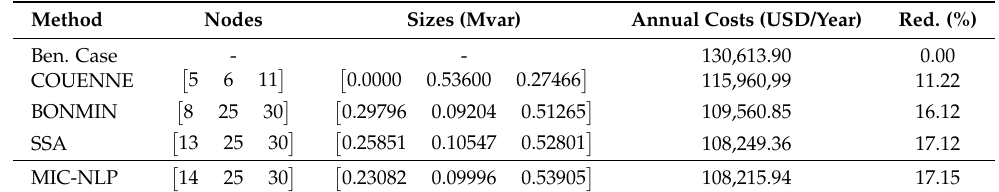
Table 5. Optimal solutions reached by the comparison and proposed optimization methods with fixed reactive power injection in a radial grid